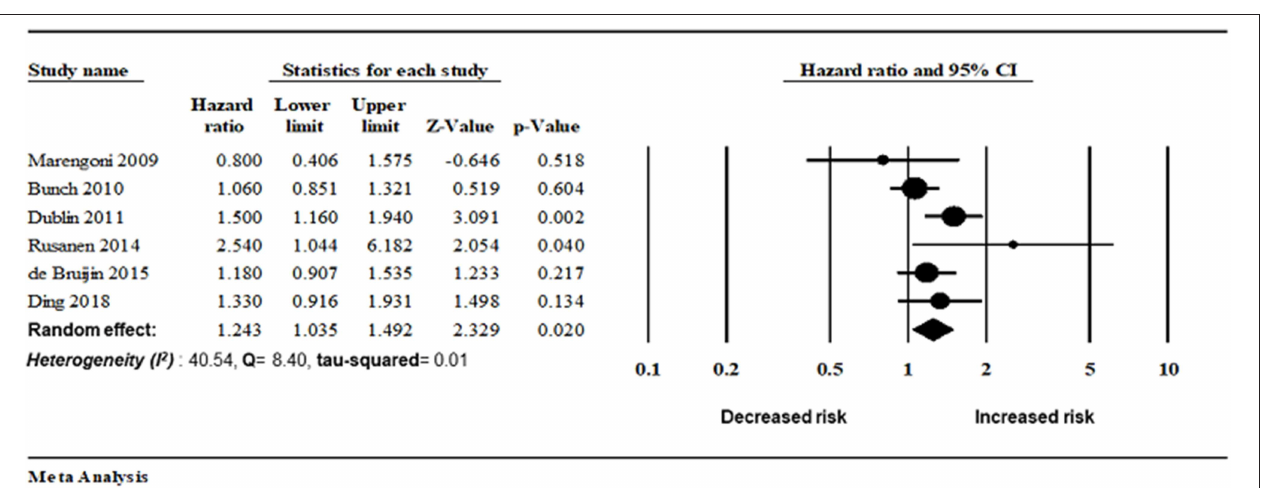
FIGURE 4 | Association between AF and Alzheimer disease